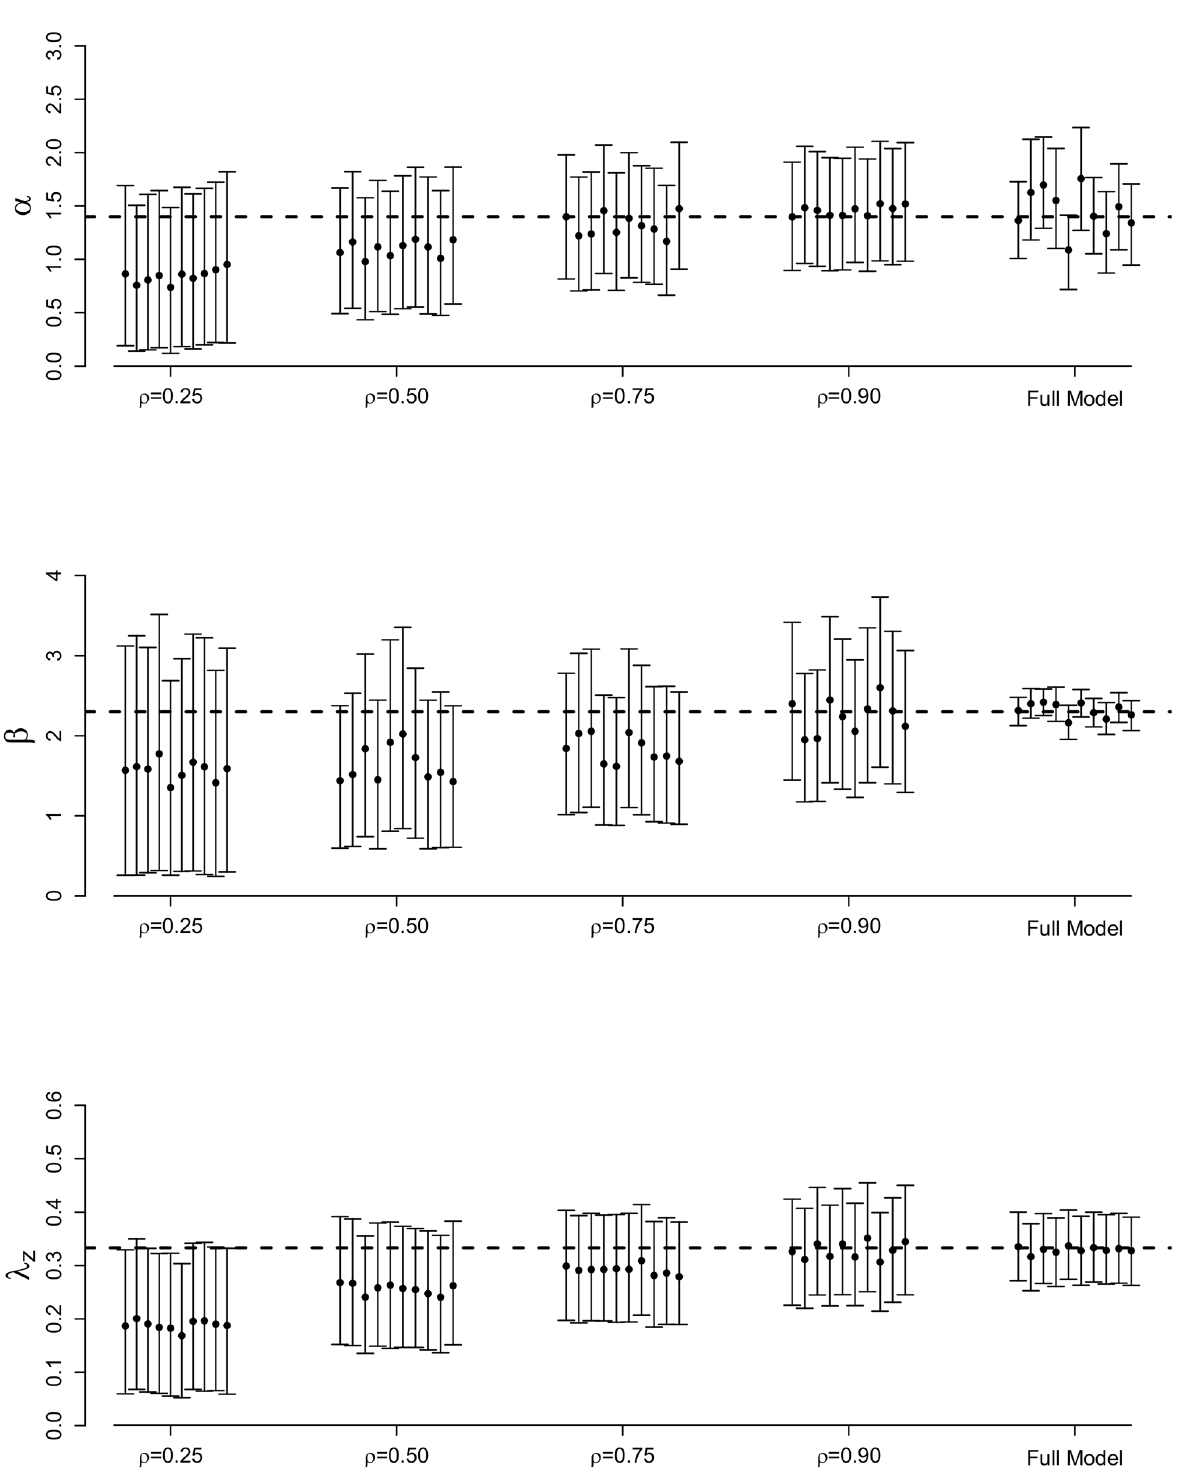
Fig 2. Posterior results for full MCMC and SRS methods. Posterior means and 95% credible intervals for α , β , and λ z for the full MCMC and SRS methods for 10 different epidemics simulated from the data augmented spatial ILM with varying sampling proportions. The dashed, horizontal lines represent the true parameter values: α = 1.4, β = 2.3, and l z ¼ 1 , with a population of size n = 625. 3